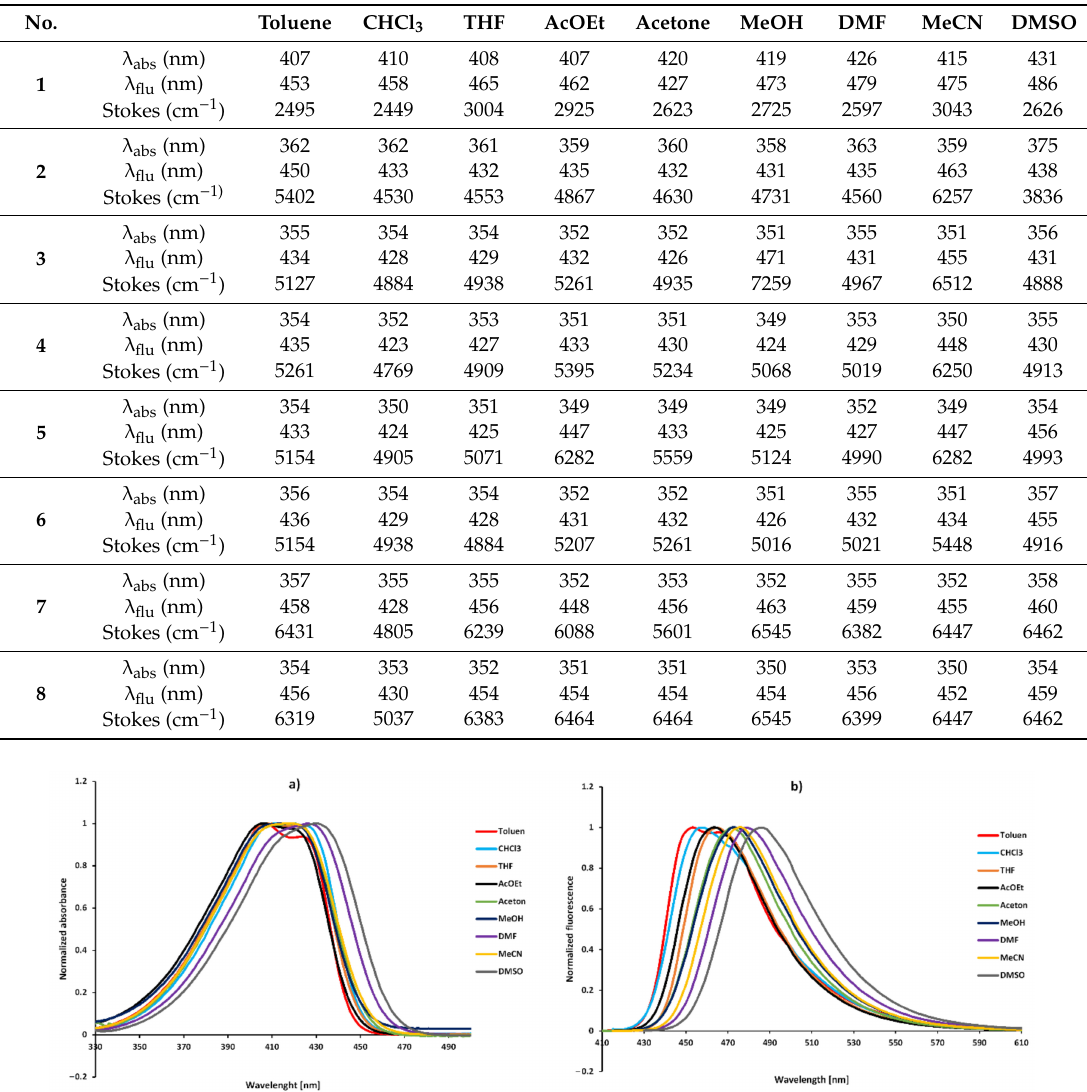
Table 3. Spectroscopic properties of 2-phenacylbenzoxazole difluoroboranes 1 – 8 in solvents of di ff erent polarity.